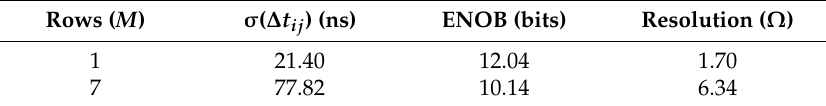
Table 2. Precision degradation due to increasing number of rows. Rows ( M )